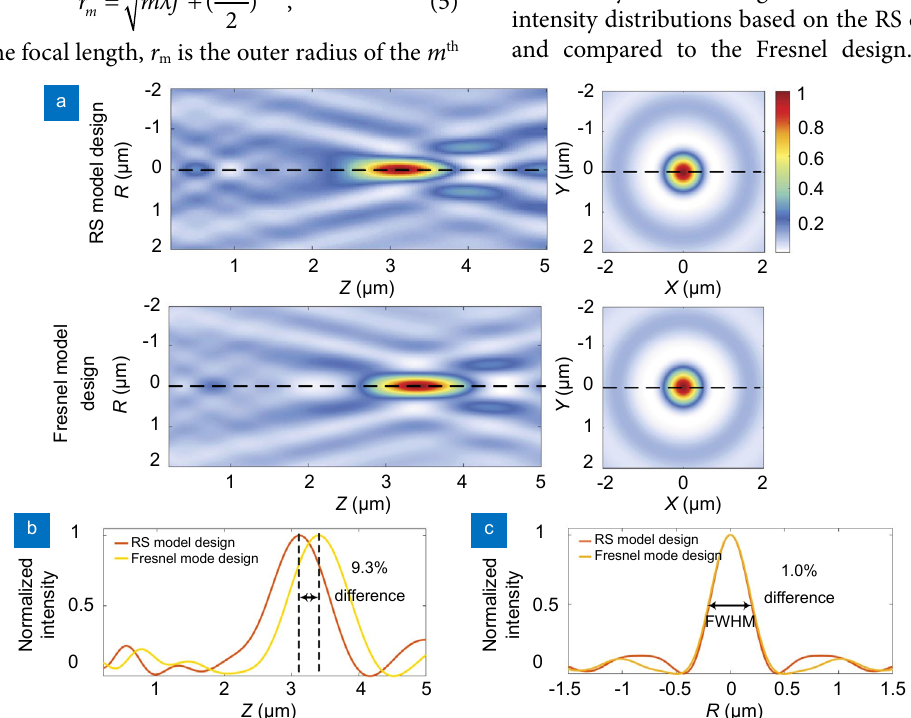
Fig. 3 | Intensity distribution of the two designs based on the RS diffraction theory . ( a ) Intensity distributions in the lateral and axial planes. ( b ) Cross-sectional intensity distribution along the black dash lines in the axial planes. ( c ) Cross-sectional intensity distribution along the black dash lines parallel to the x axis in the lateral